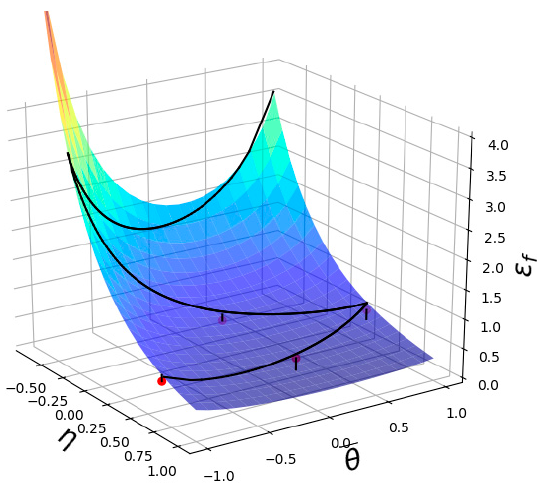
Figure 1 . Representation of fracture locus in space. Figure 1. Representation of fracture locus in